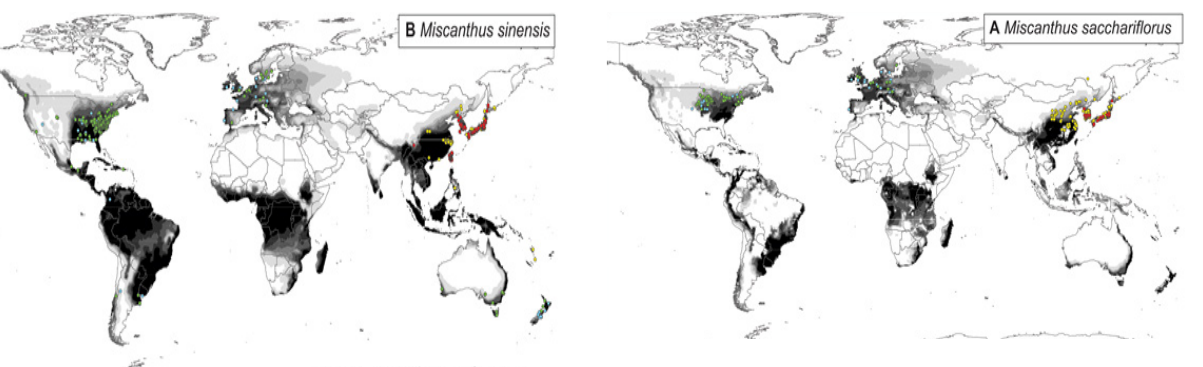
Figure 2 Distribution of Chinese Miscanthus ( M. sinensis )